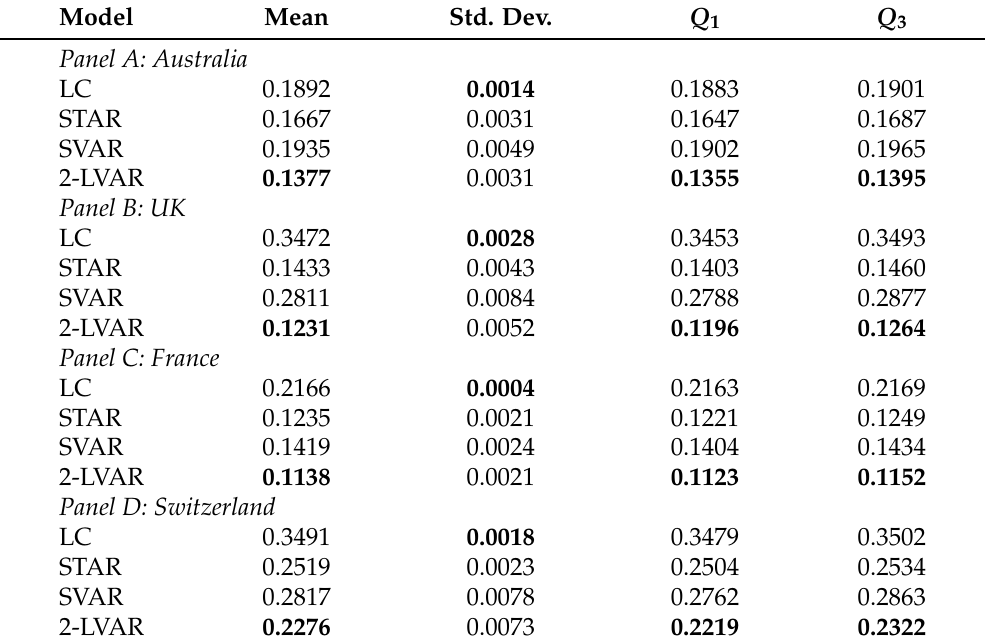
Table 2. Summary of simulation